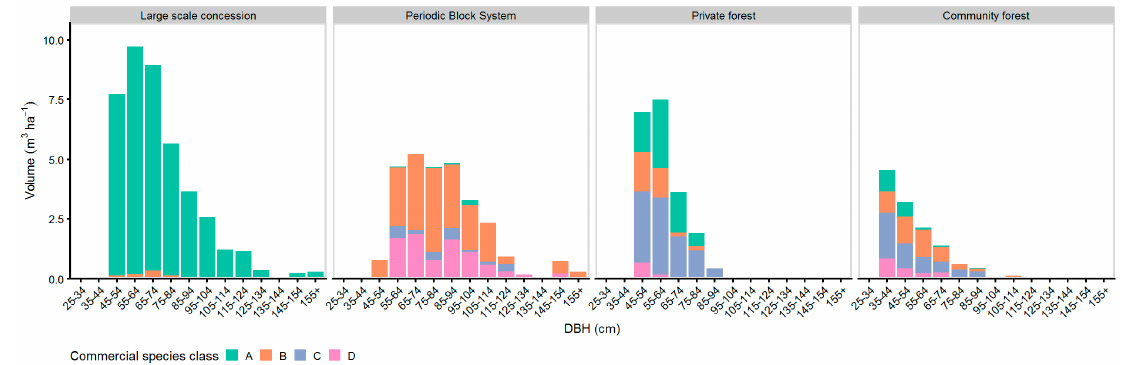
Figure 9. DBH-histogram of commercial species classes of trees with LG 1 & 2 selected for harvest.